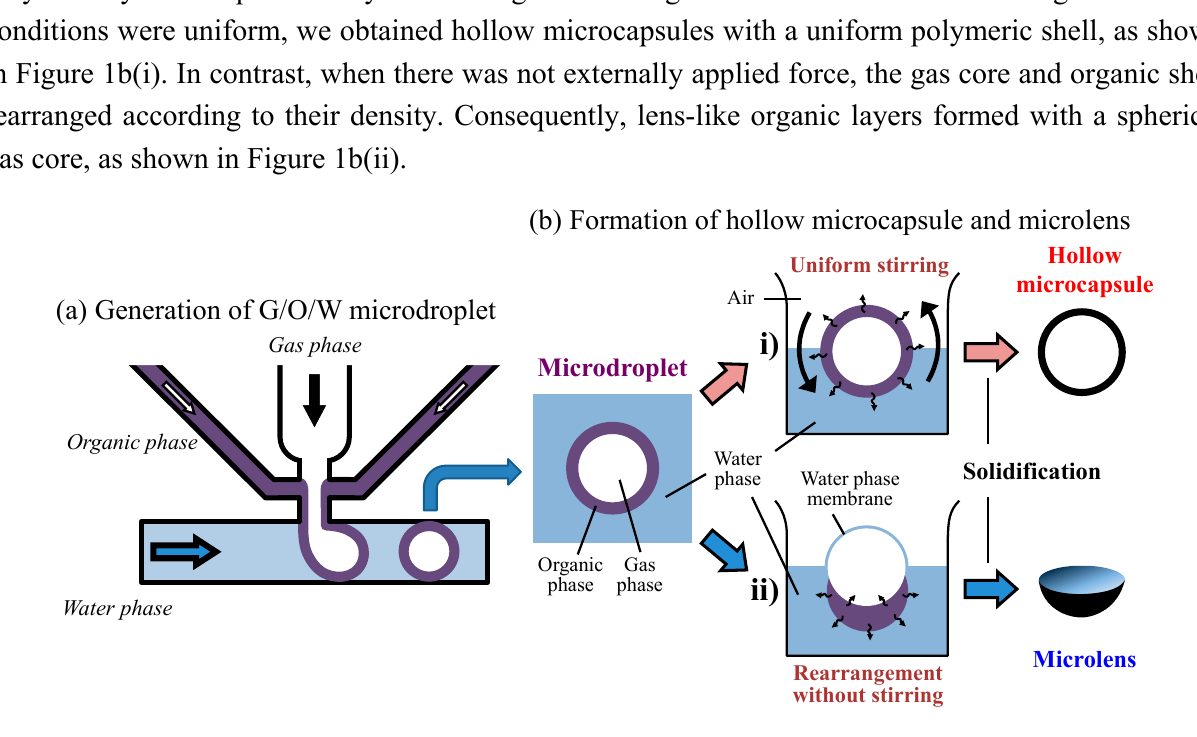
Figure 1. Steps in the formation of microcapsules and microlenses using gas-in-organic-in-water (G/O/W) microdroplets. ( a ) Generation of G/O/W microdroplet; ( b ) formation of hollow microcapsule and microlens.